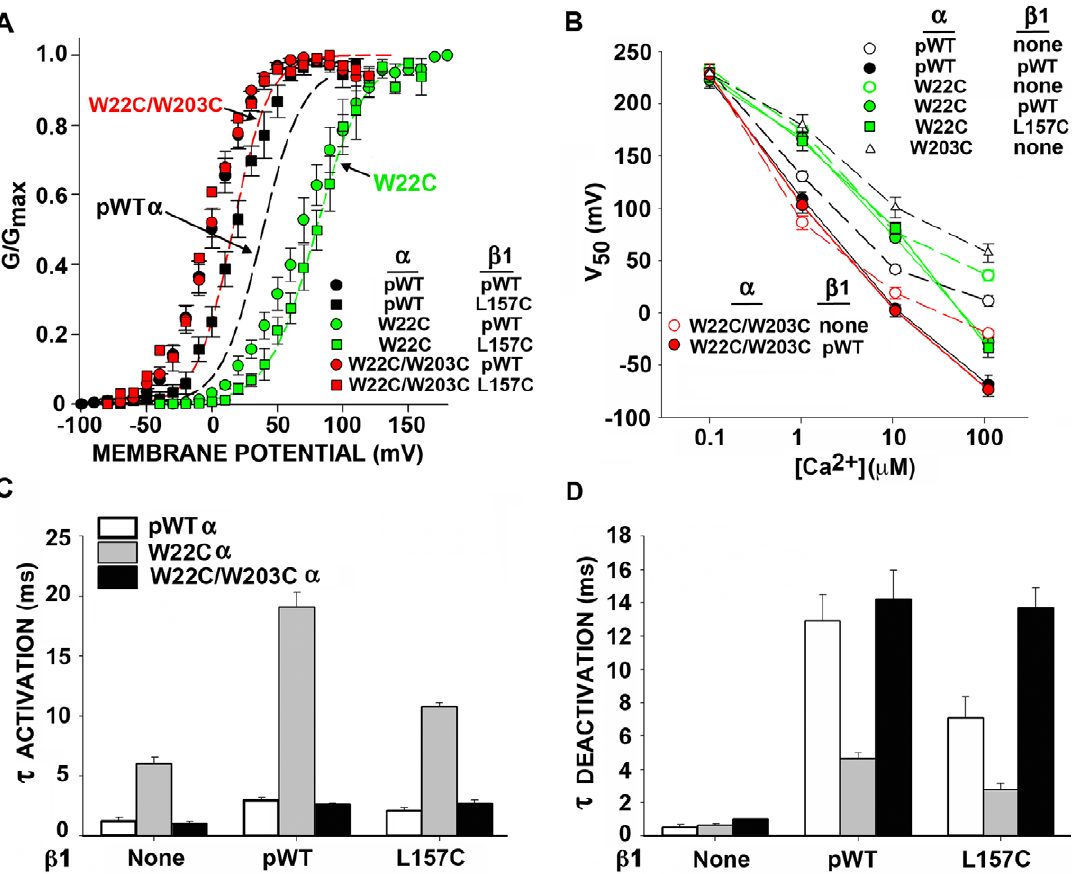
Figure 7. Effects of the mutations W22C in S0, W203C in S4, and L157C in TM2, singly and in combination, on BK channel function. (A) Normalized G-V curves. The data for the combinations of a and b 1 are shown as individual points. The data for a alone are shown as fitted curves. (B) V 50 as a function of [Ca 2 + ] IN for various combinations. (C) Tau ACTIVATION and (D) Tau DEACTIVATION for various combinations of pWT1 a or mutant a and b 1 or b 1 L157C or without b 1. Errors are SEM. N=3–9.